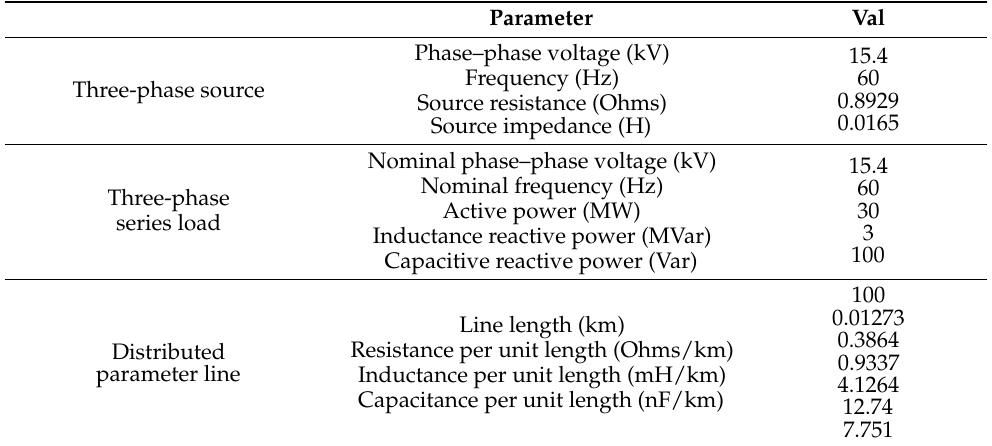
Table 3. Simulation